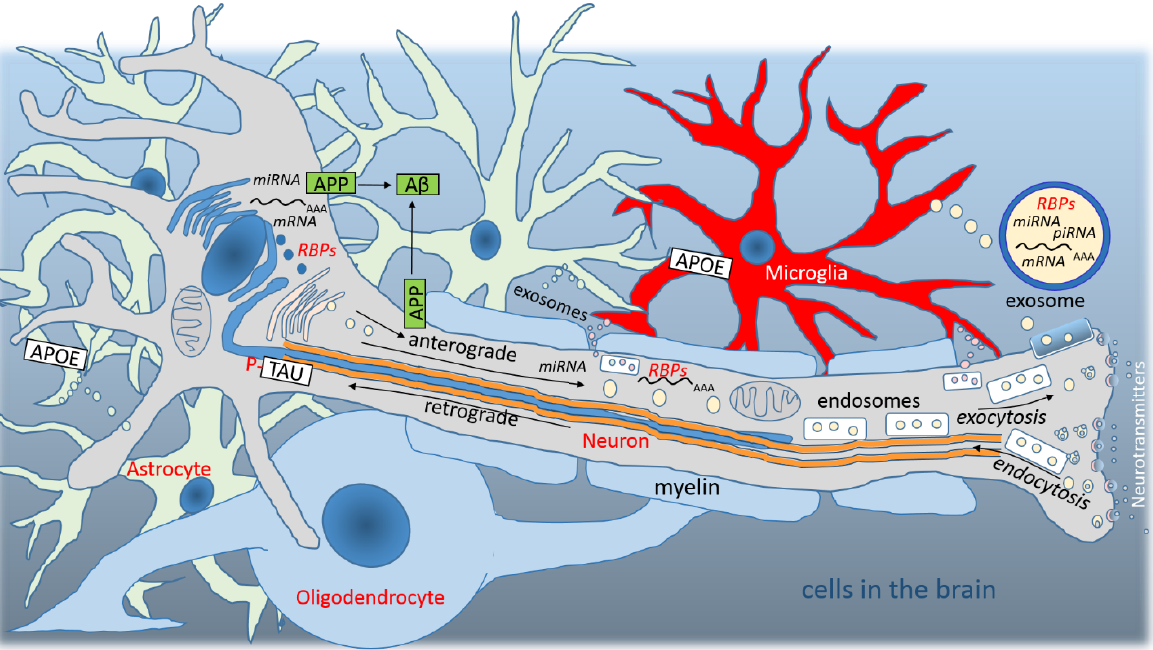
Figure 1. Graphic representation of cells in the brain. Nerve mRNAs and RBPs are transferred from the nucleus via the axon (exosomal pathway, anterograde), and glial mRNAs and RBPs are transferred from the extracellular space to the nucleus (endosomal pathway, retrograde). Dysregulation of APP/Aβ, TAU , and APOE functions are the basic three characteristics of AD. Due to the dysregulation of these three genes/proteins, disruption of axonal transport can be observed in AD.